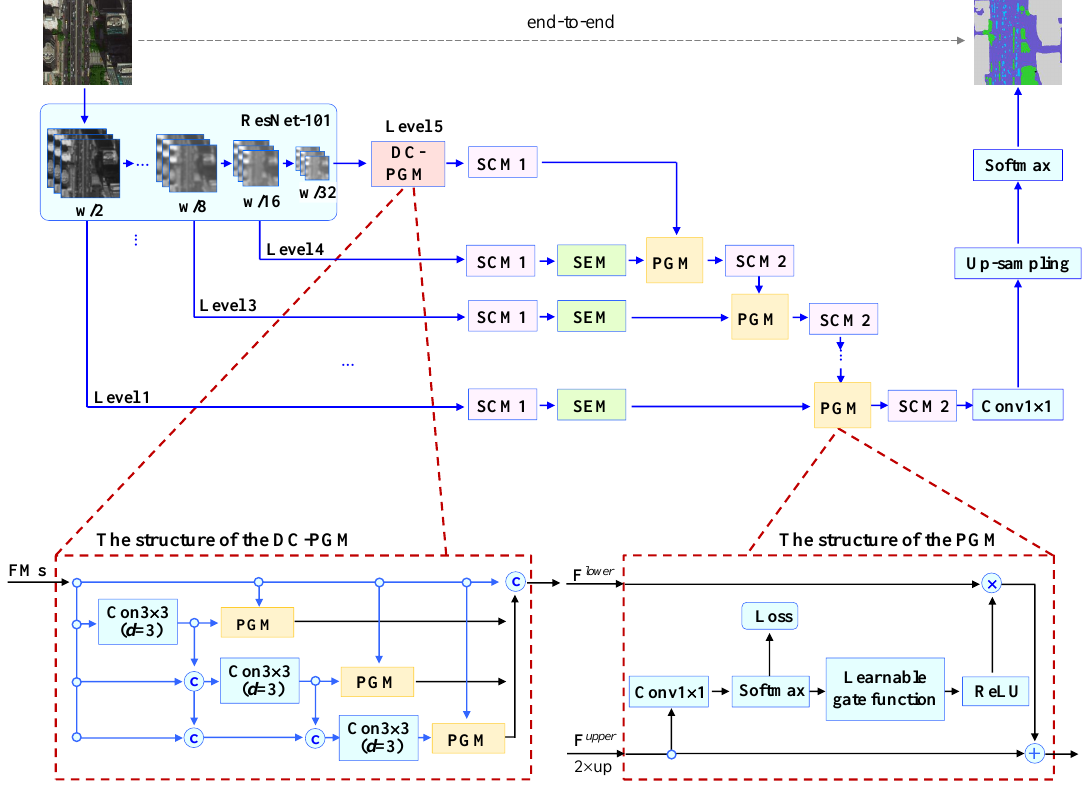
Figure 1. Overview of the model Learnable Gated Convolutional Neural Network (L-GCNN) for remote-sensing (RS) image segmentation. In the encoder part, ResNet-101 is used as feature extractor. In the decoder part, the Parameterized Gate Module (PGM) and Densely Connected PGM (DC-PGM) are proposed for feature fusion. In addition, the Shortcut Convolution Module (SCM) and Squeeze-and-Excitation Module (SEM) were employed as basic processing units. Details of PGM and DC-PGM are shown in dashed